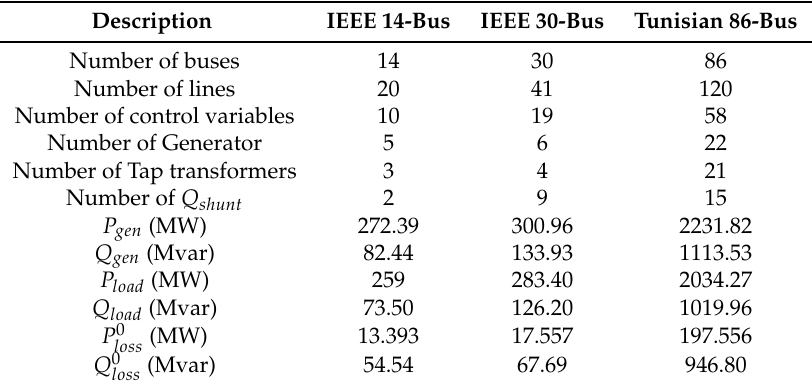
Table 1. Description of test systems.